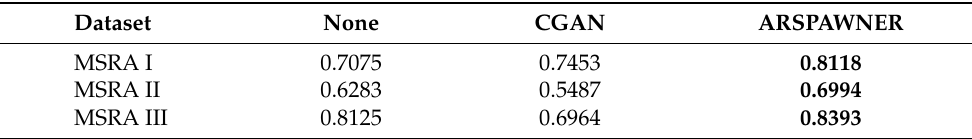
Table 6. Comparison of CGAN and ARSPAWNER on the MSRA datasets. The best result for each dataset is written in